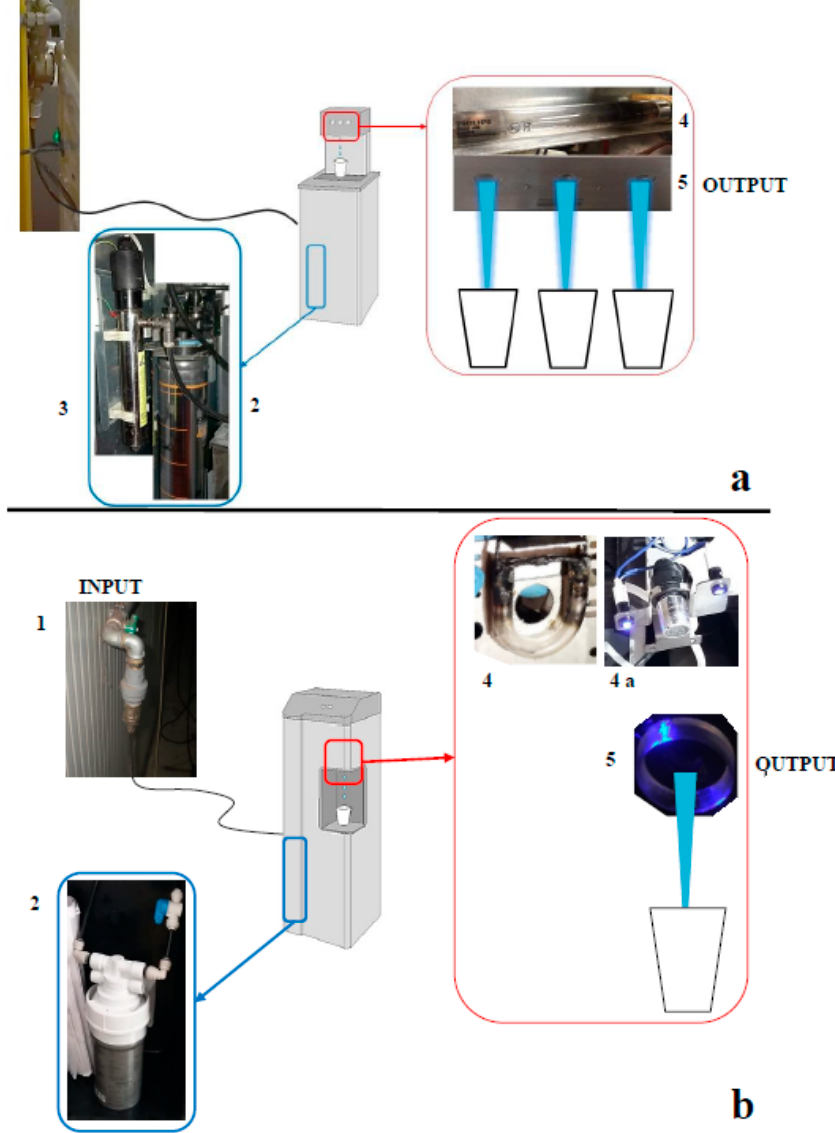
Figure 1. Schematic representation of MWDs (microfiltered water dispensers): ( a ) Type A and ( b ) Type B. (1: Input from municipal water, 2: carbon filter, 3: ultraviolet (UV) inner lamp, 4: UV lamp at water supply point, 4a: UV lamp, without glass and water supply point (output), and 5: water supply points (output)).